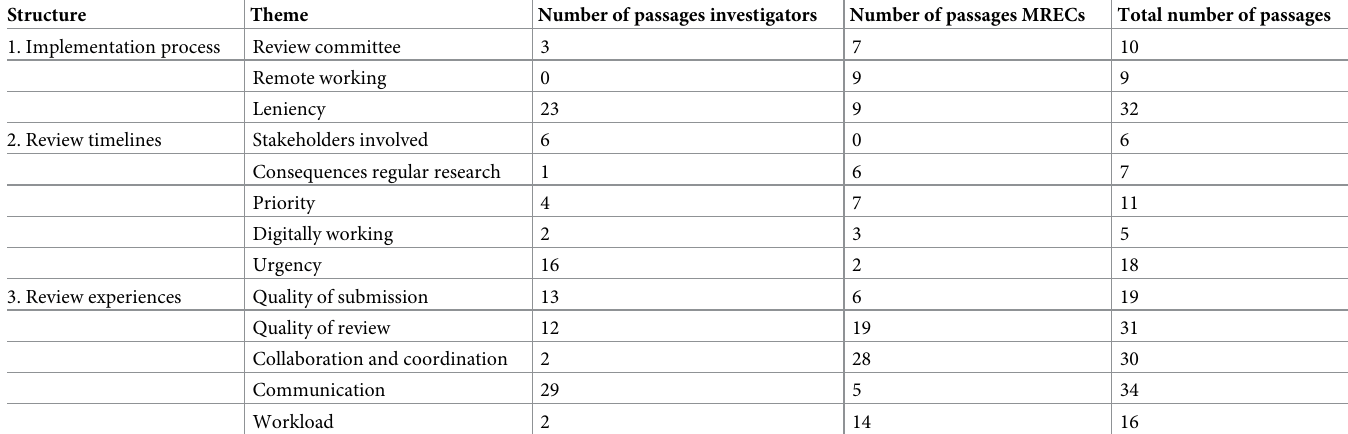
Table 6. Code structure and theme frequencies. (one code per discussion point per